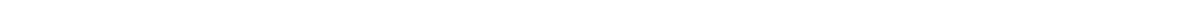
Fig. 5 Lis1 and LINC complex function is required for invadopodia assembly and activity. a Effect of Lis1 KD on invasion speed of MDA-MB-231 cells expressing H2B GFP in 3D collagen gels polymerized at 37 °C or 20 °C (as in Fig. 1e). n , number of cells analyzed from three independent experiments. Data were transformed using the log transformation y = log (y) to make data conform to normality and analyzed using one-way ANOVA test. b Pericellular collagenolysis (mean Col1- 3 ⁄ 4 C signal per cell normalized to mean intensity of siNT-treated cells ± SEM) by MDA-MB-231 and HT-1080 cells silenced for Lis1 or Nesprin-2 in collagen polymerized at 37 °C (as in Fig. 1k). n , number of cells analyzed from three independent experiments. Kruskal – Wallis test